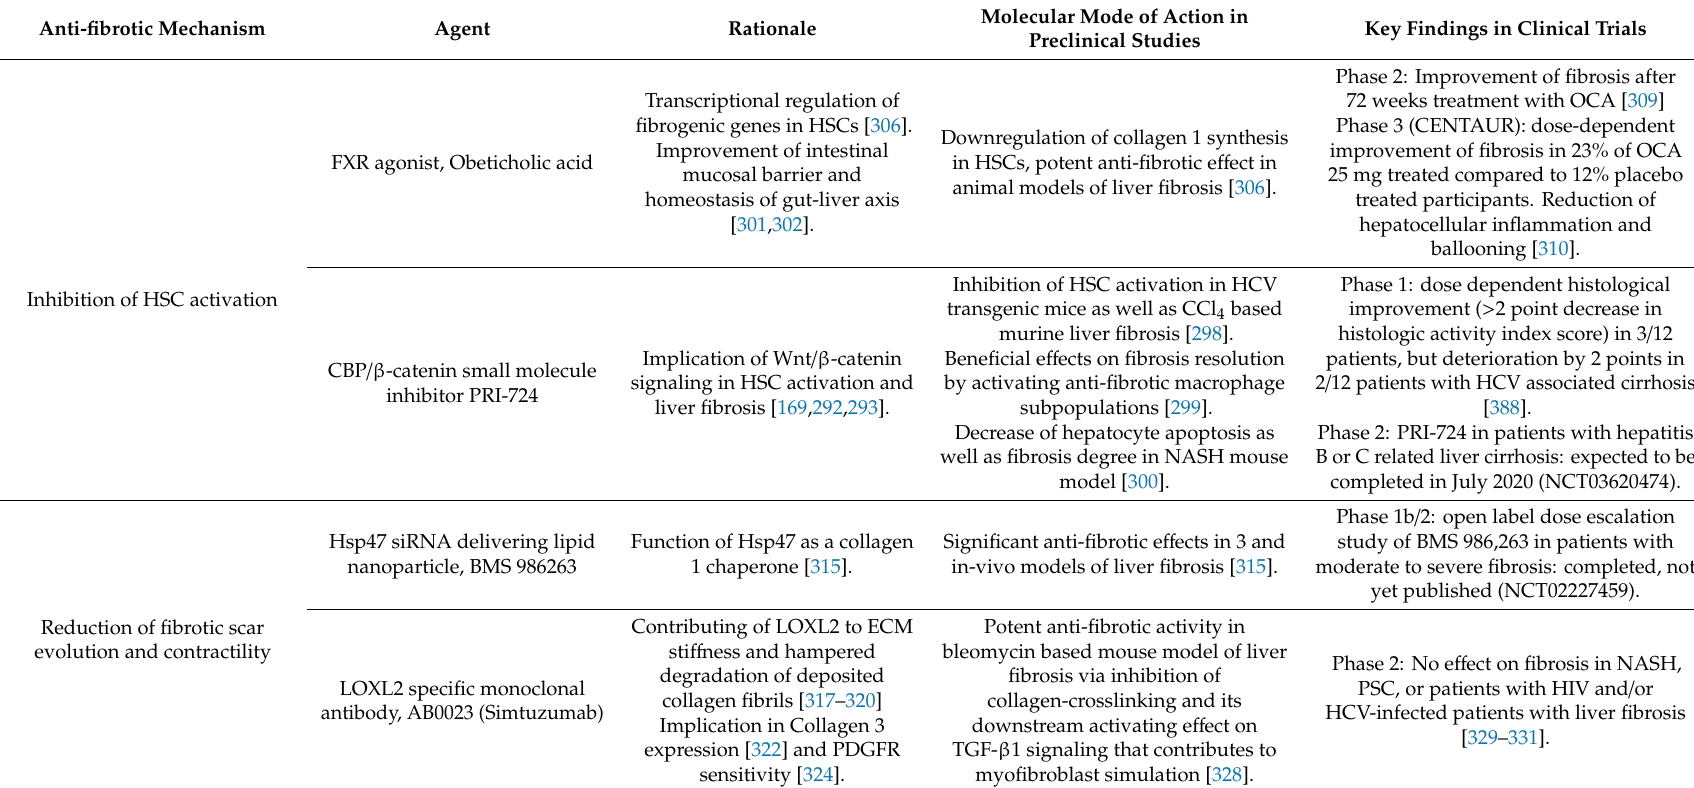
Table 2. Examples for compounds in clinical development aiming to reduce fibrosis by inhibition of HSC activation and reduction of fibrotic scar